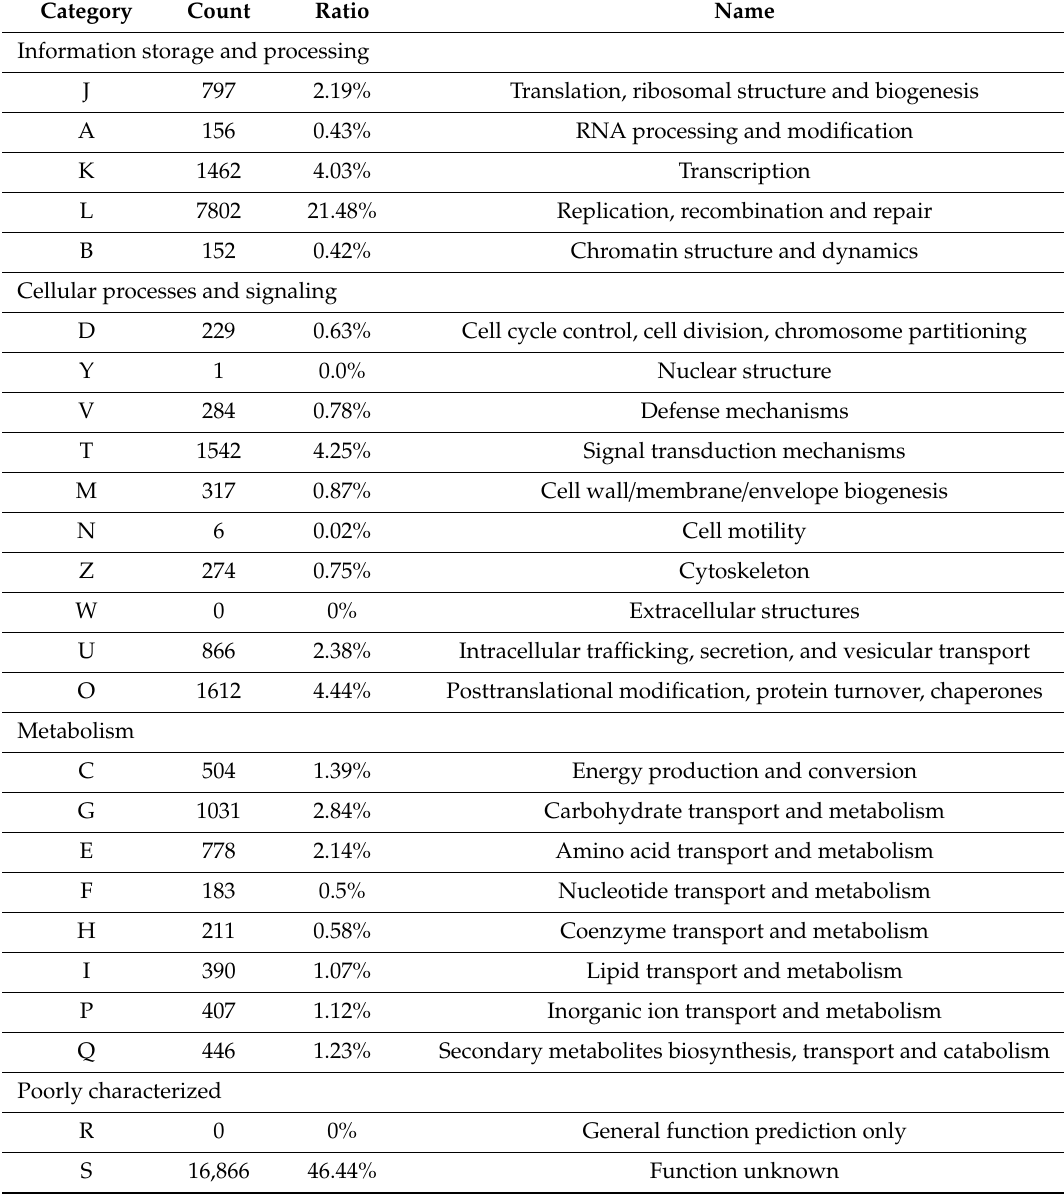
Table 1. Summary of EggNOG annotation count and ratio for functional